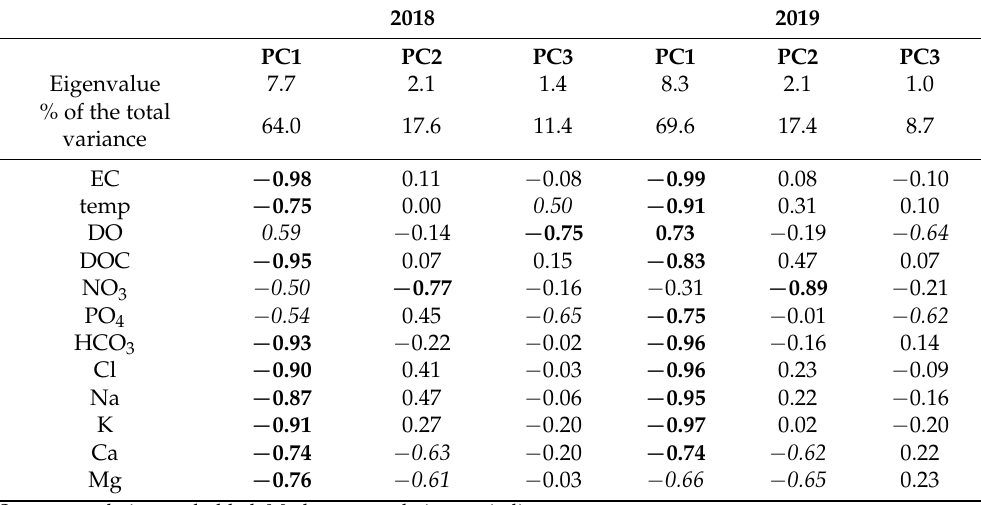
Table 4. Factor loadings of variables calculated based on the annual average values of the determined parameters for 2018 and